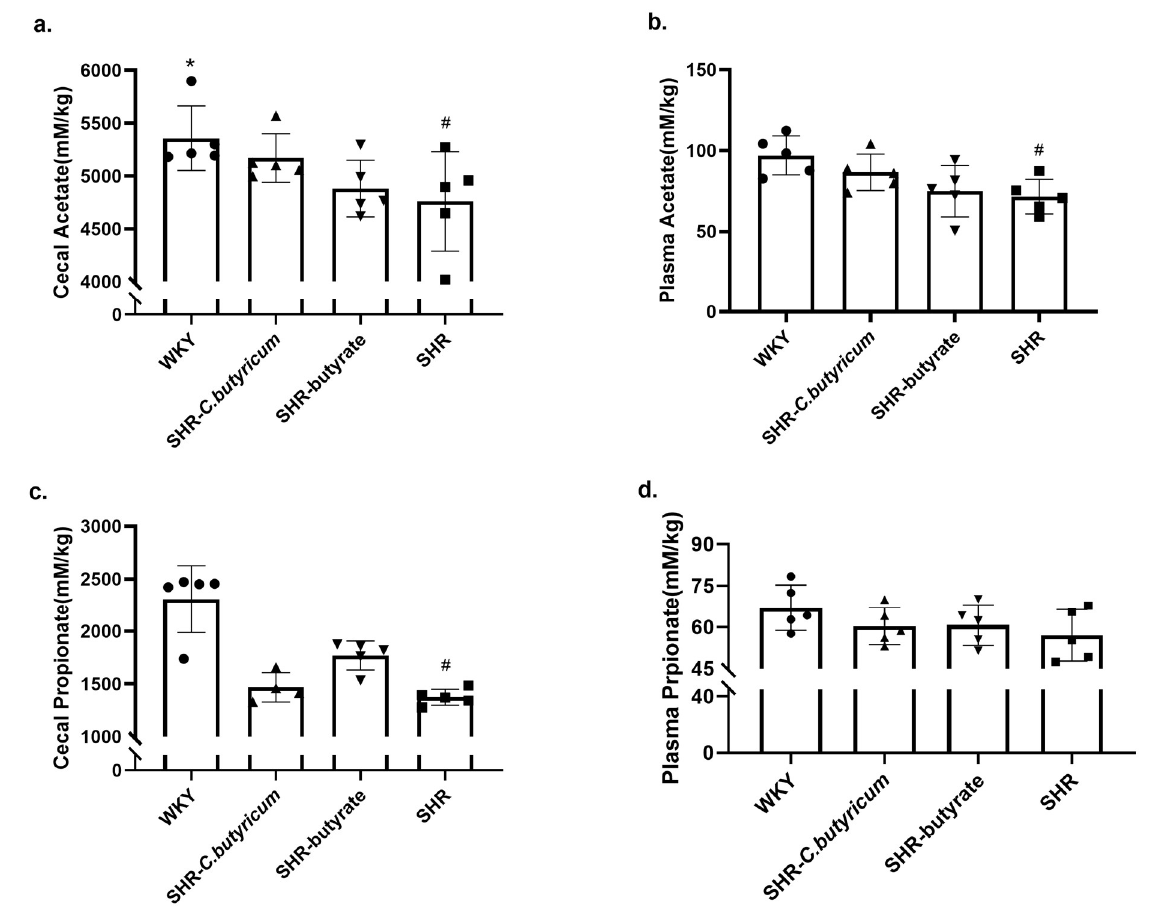
Figure 6. SHR reduced cecal and plasma SCFAs concentration, which was prevented by C. butyricum and butyrate. ( a , b ) Cecal and plasma acetate concentration was increased by C. butyricum and butyrate (n = 5 per group). ( c , d ) the reduction in propionate concentration in SHR cecal and plasma was prevented by C. butyricum and butyrate (n = 5 per group). Data are shown as the mean ± S.E.M., * p < 0.05 for SHR vs. SHR- C. butyricum or SHR-butyrate. # p < 0.05 for SHR vs. WKY.